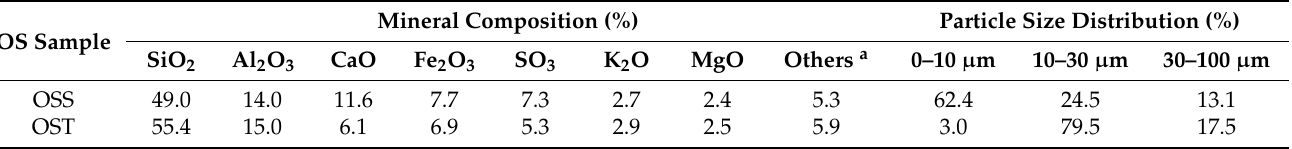
Table 2. Composition and particle size distribution of the solids in OS.